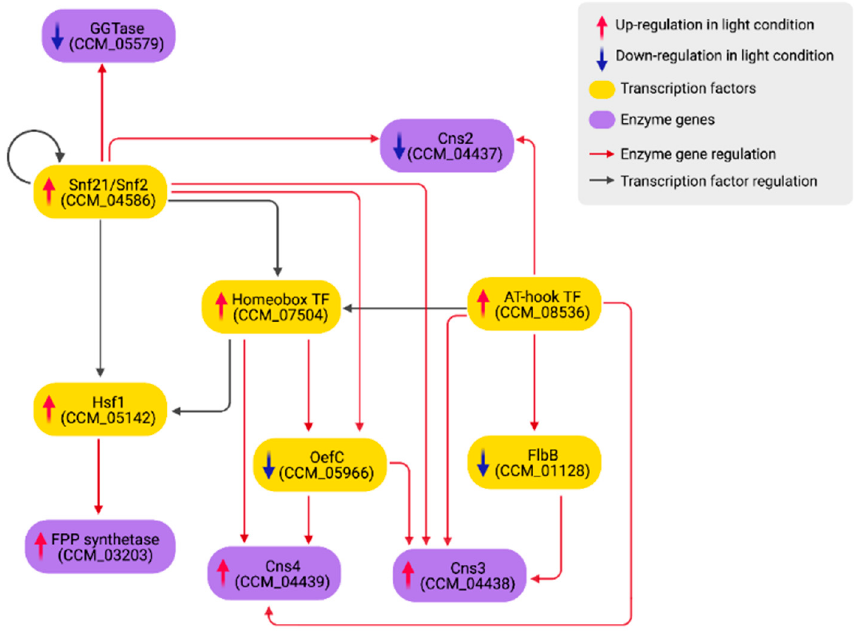
Figure 6. The regulatory sub-network of cordycepin/pentostatin (Cns2, Cns3 and Cns4) and carotenoid (GGTase and FPP synthetase) biosynthesis controlled by the key